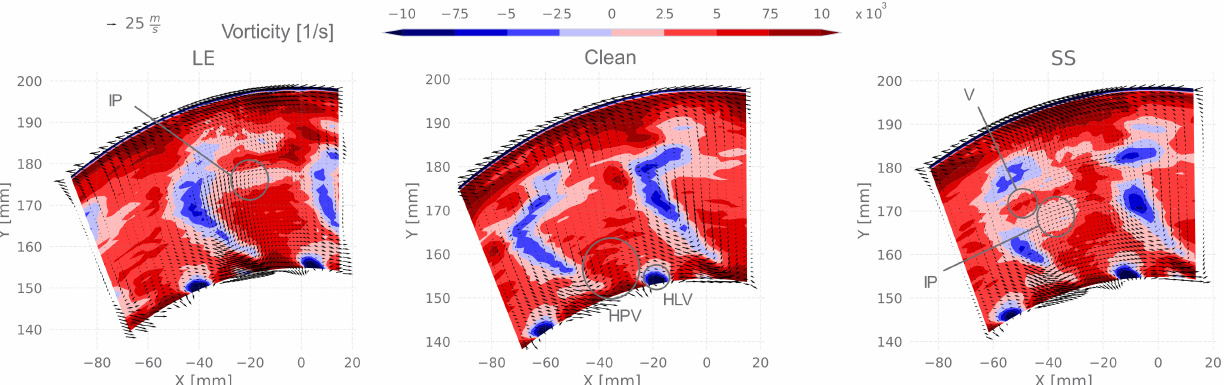
Figure 8. Vorticity contours at plane T2 for the cases “Clean”, “LE 10 Hz” and “SS 10 Hz”. Vectors represent the velocity magnitudes projected on a plane perpendicular to the stator geometrical discharge